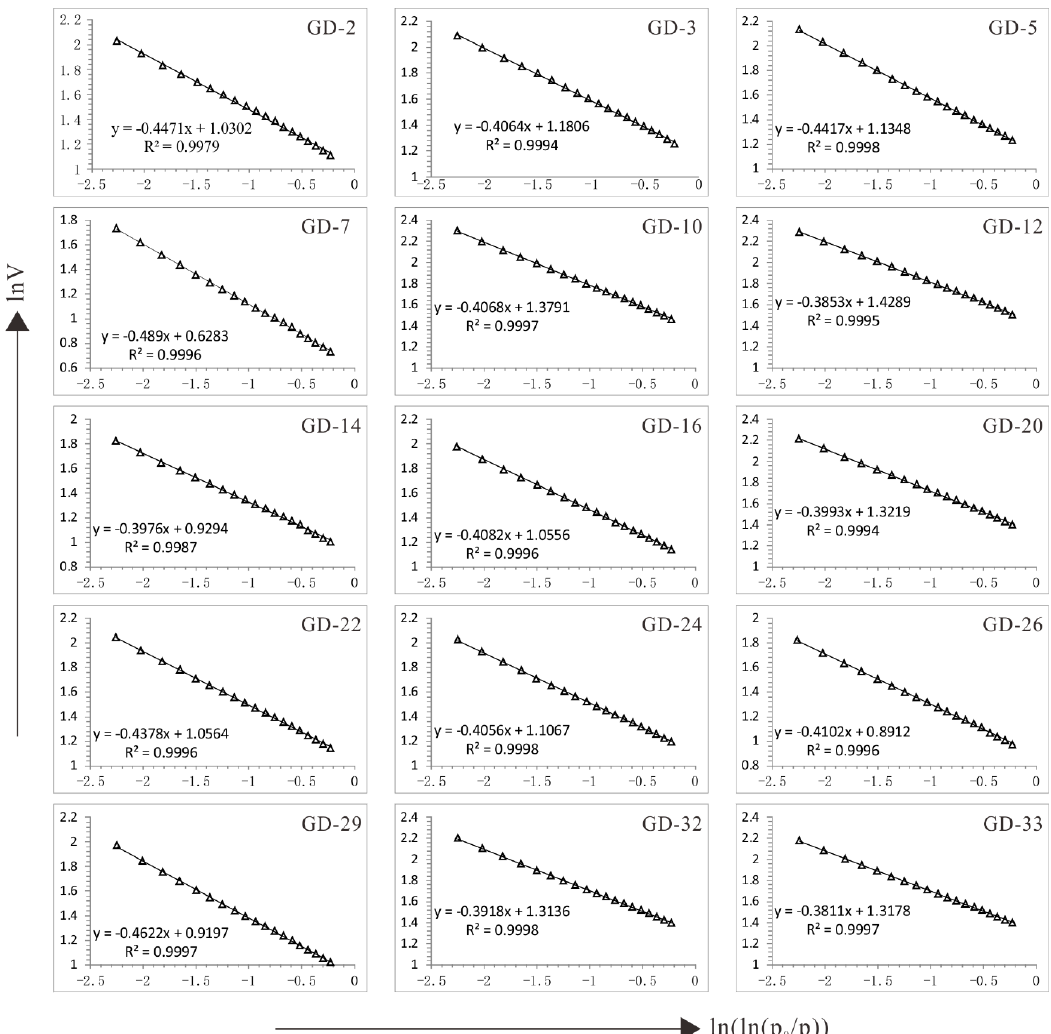
Figure 9. The fractal dimensions of the Dalong Formation shales. P is the equilibrium pressure, MPa; P 0 is the saturation pressure, MPa; V is the volume of adsorbed gas molecules at the equilibrium pressure p, cm 3 /g; V 0 is the monolayer coverage volume, cm 3 /g.